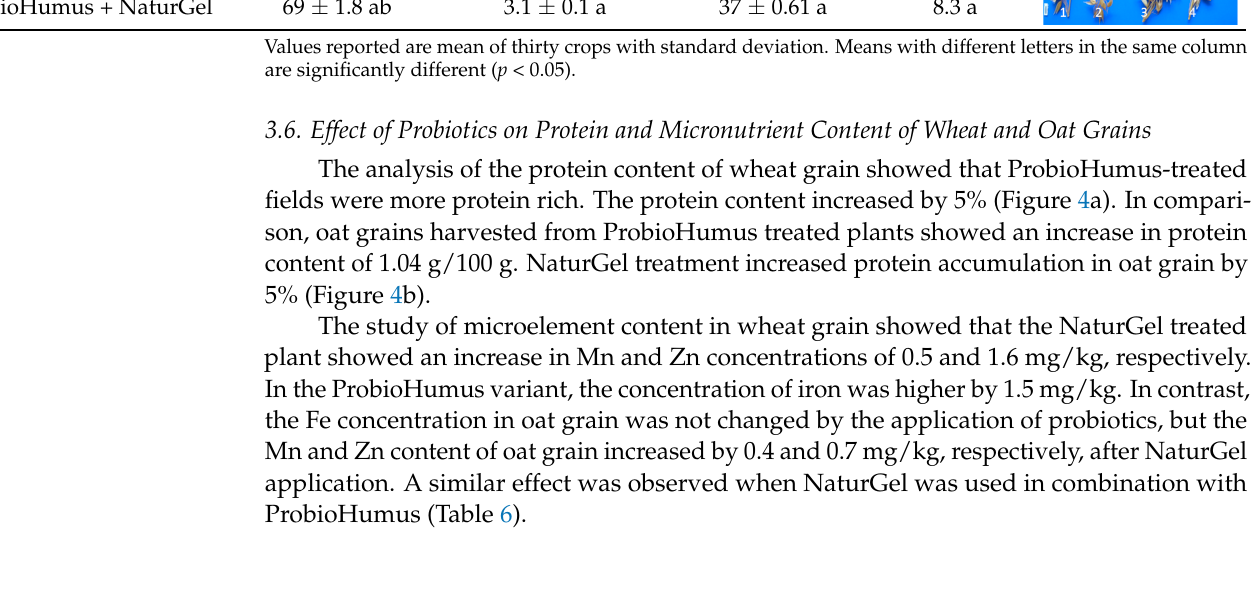
Table 4. Effect of probiotic preparations on wheat grain yield formation at full maturity stage.